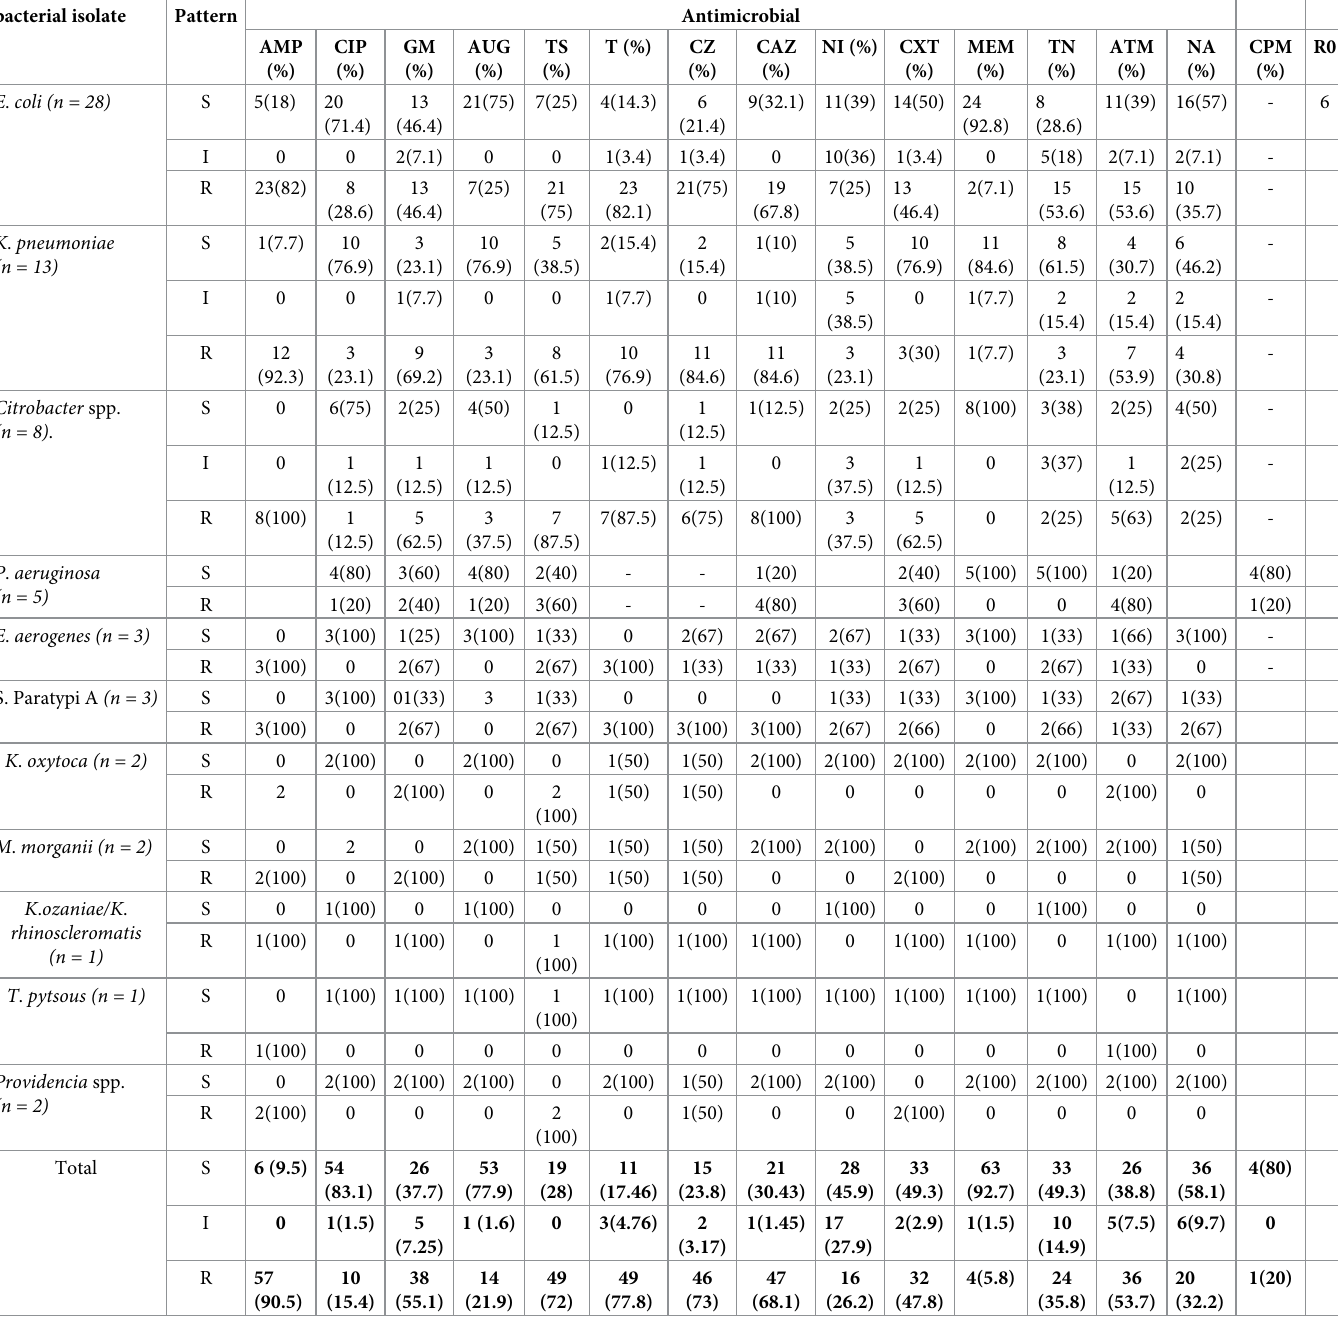
Table 4. Antimicrobial susceptibility pattern of gram-negative bacteria isolated from the urine of under-five children attending at HFSUH, eastern Ethiopia, 2021. bacterial isolate